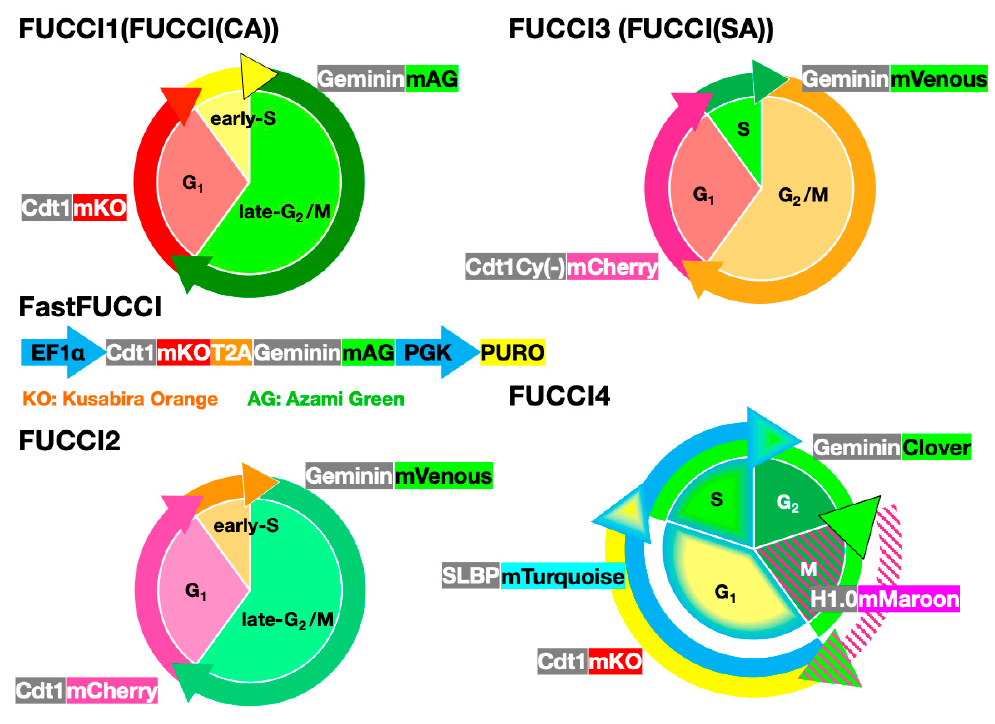
Figure 2. Comparison of the di ff erent FUCCI